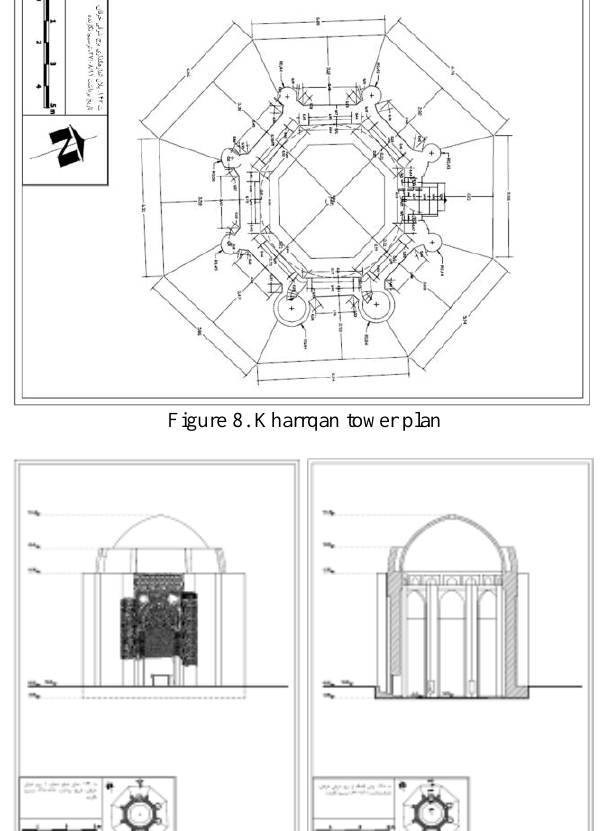
Figure 9. Left: Elevation of first side of the tower, Right: A section of the tower